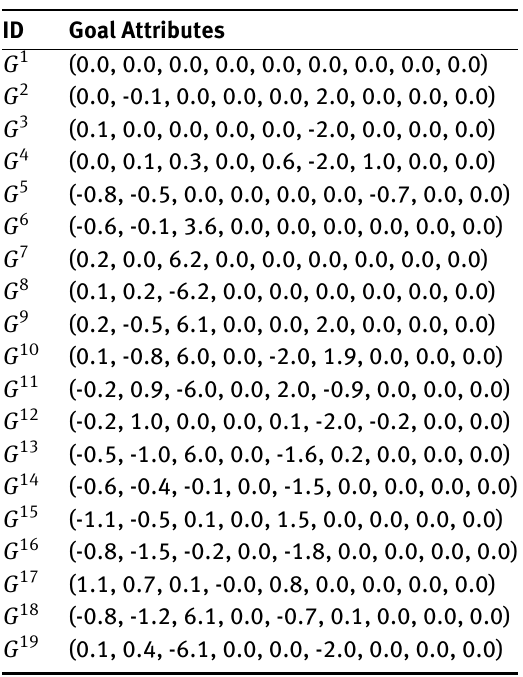
Table 9: Achievement goal prototypes generated in the first run of experiment 4 with ρ A = 0.9. Weights are rounded to 1 decimal place.